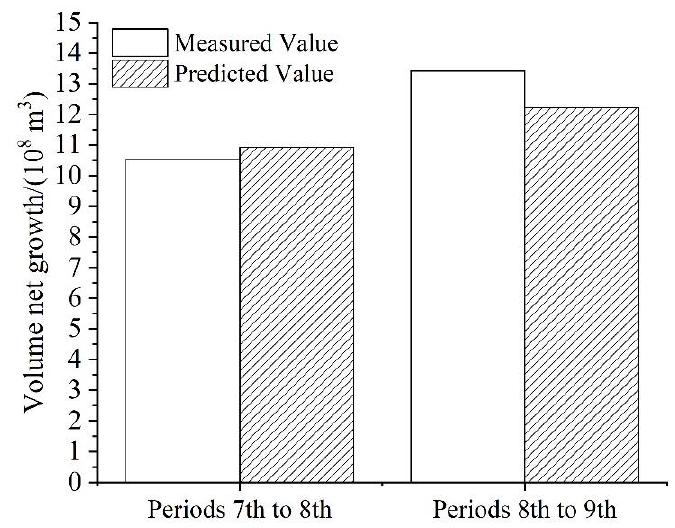
Figure 2. Comparison between the measured value in the NFI and predicted value by the RF model.